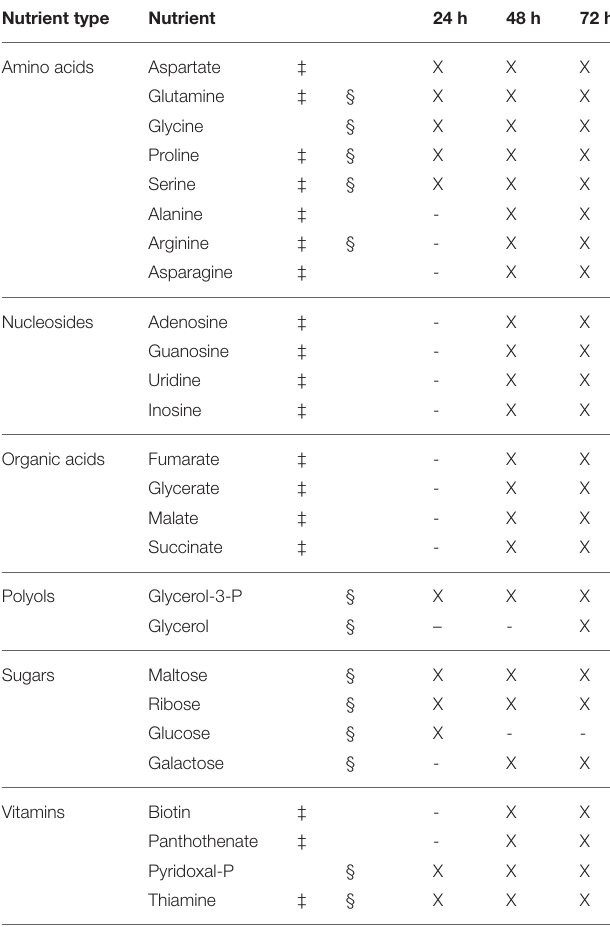
TABLE 3 | Temporal utilization of nutrients by S. enterica in germinating alfalfa exudates that serve as sole C- or N-sources* or vitamins. Nutrient